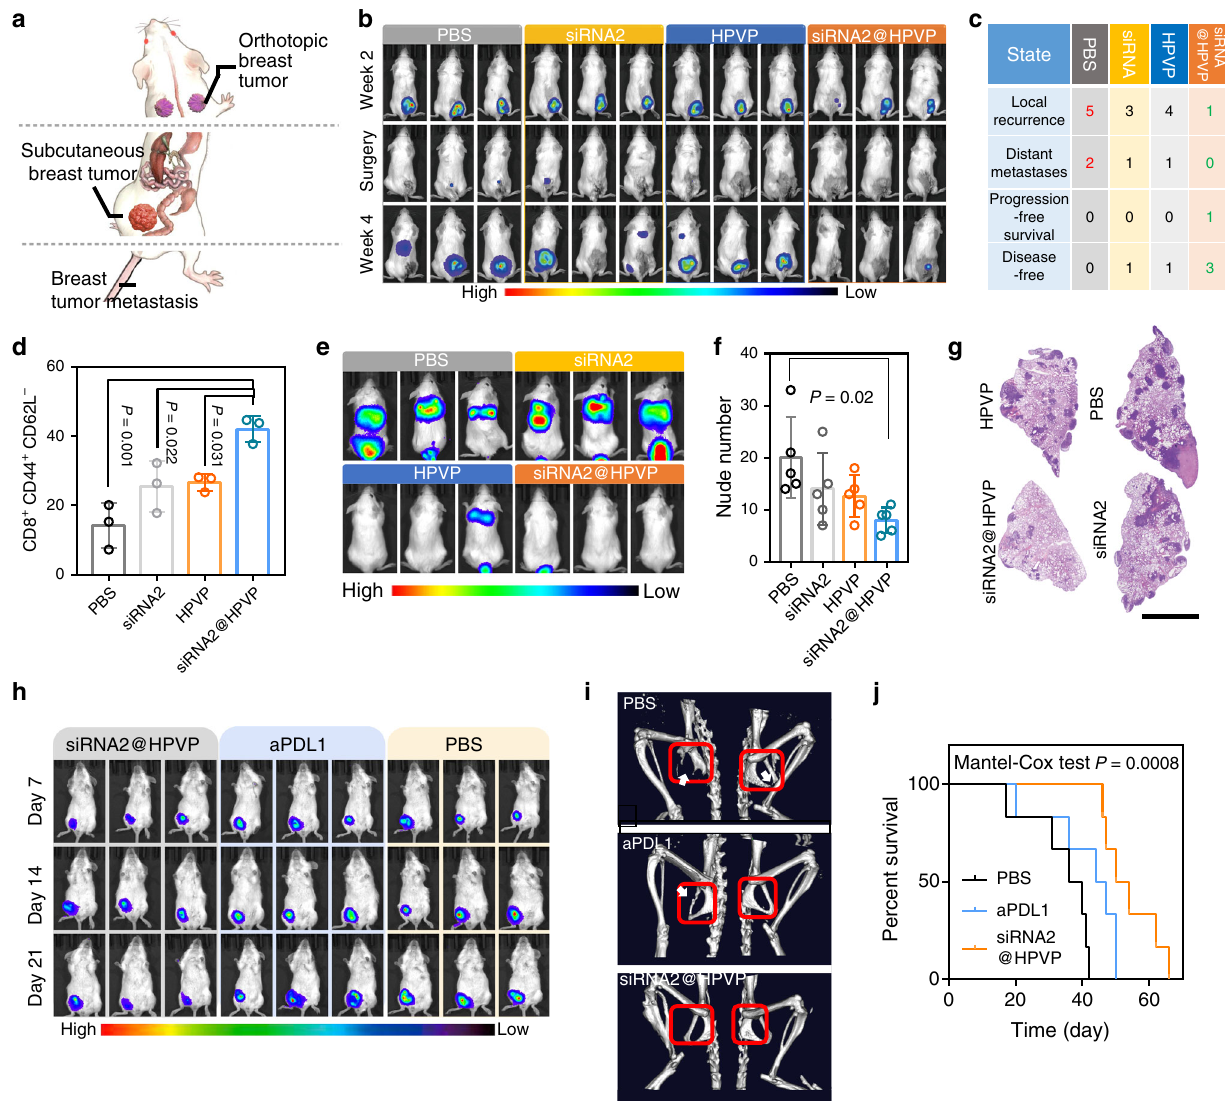
Fig. 5 Therapeutic effect in resectable and unresectable tumor models. a Different tumor models established in this study for evaluating the anticancer effect of siRNA2@HPVP treatment. b In vivo bioluminescence images to track the recurrence and metastasis of 4T1 tumors after the resection of the primary tumor. The resection operation was conducted 15 days after different treatments. Three representative images of fi ve biological replicates are shown. c The data of the lesion condition in the resectable murine breast tumor model after the resection of primary tumor. s@H represents siRNA2@HPVP. d The proportion of T EM cells (CD8 + CD44 + CD62L − ) in spleen tissues 40 days after different treatments. The primary tumor was removed by surgery at day 15. Three biological replicates are shown. e In vivo bioluminescence images to exhibit the anti-metastasis effect of various treatments. The metastatic breast tumor model was constructed by intravenously injecting BABL/C mice with 4T1 luc cells. The treatments were carried out 24 h after the tumor cells injection. Three representative images of fi ve biological replicates are shown. f , g H&E staining and quantitative counting of metastatic nodes in lung tissues 21 days after the i.v . injection of 4T1 cells (Scale bar: 5 mm). Five images per group were taken. h In vivo